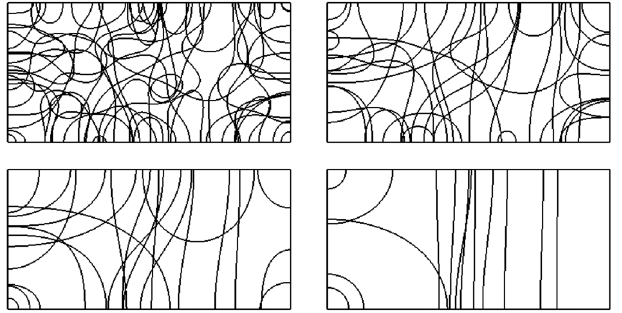
FIG. 11. Evolution of isoglosses in a 400 × 200 rectangular system with uniform population density, starting from random- ized initial conditions. We show a superposition of 10 such solutions. Notice that all isoglosses join the two long sides of the system. Parameter values σ ¼ 4 , β ¼ 2 . Evolution times t ¼ 30 , 90, 270, 810.